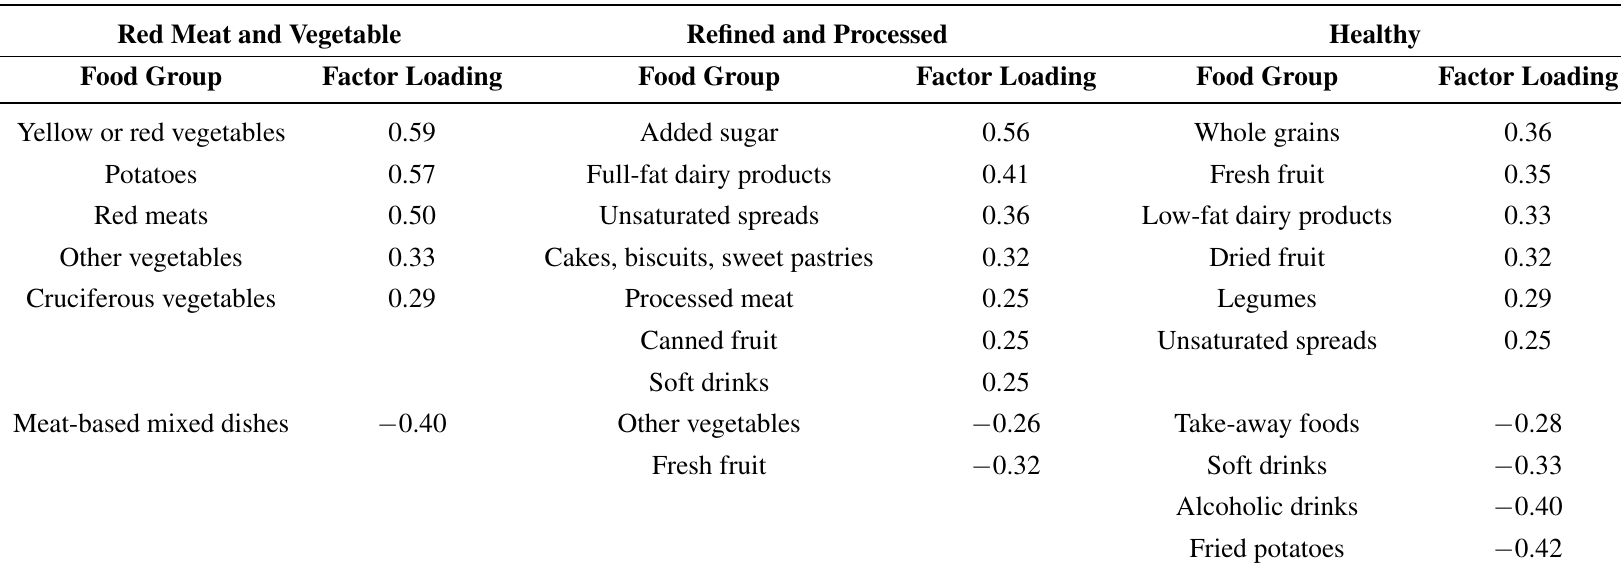
Table 2. Dietary patterns of the adults aged 45 years and over participating in the 2011–2013 Australian Health